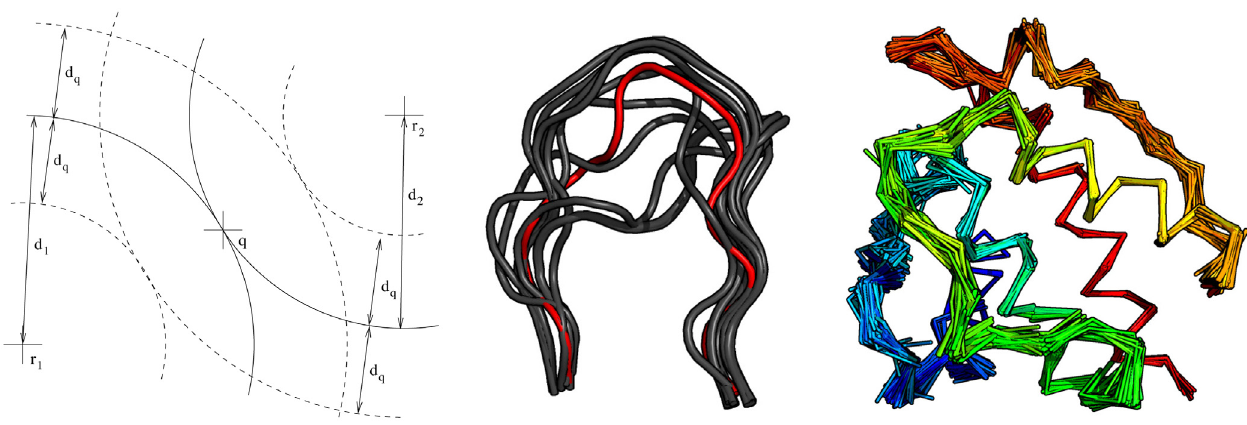
Figure 1. Left: pruning the fragment space for query distance d fragment r (resp. r ). Only fragments which are both within d 1 2 loops that can connect residue ALA 98 to GLY 110 in chain A of PDB 1MEL. The query loop is shown in red. Only its first and last three residues were used to rank the retrieved fragments. Right: Backbone of PDB 1BKR covered with ten residue fragments from non-homologous proteins retrieved with